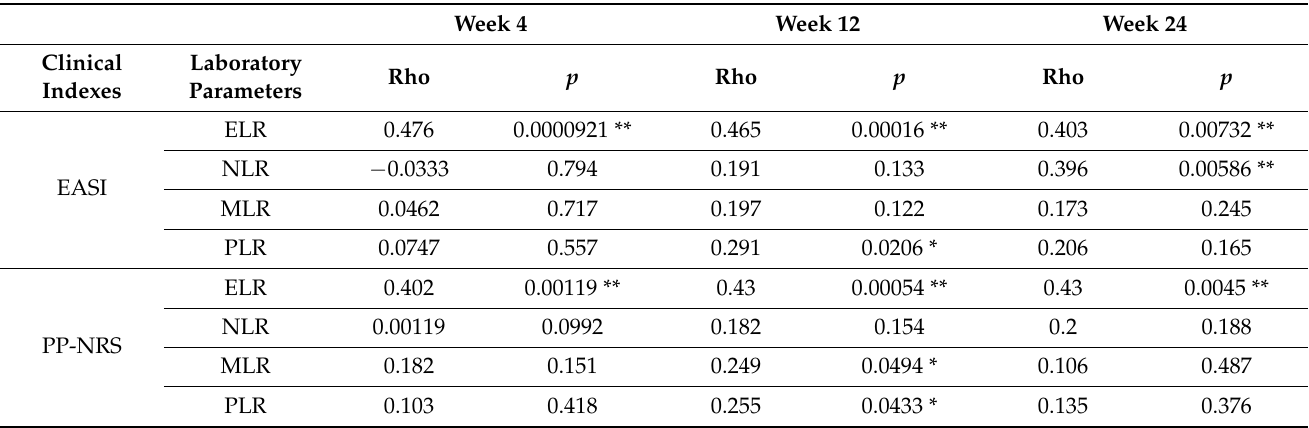
Table 3. Correlations between percent reductions of laboratory parameters versus those of clinical indexes at weeks 4, 12, or 24 of treatment with upadacitinib plus topical corticosteroids in patients with atopic dermatitis ( n = 65).